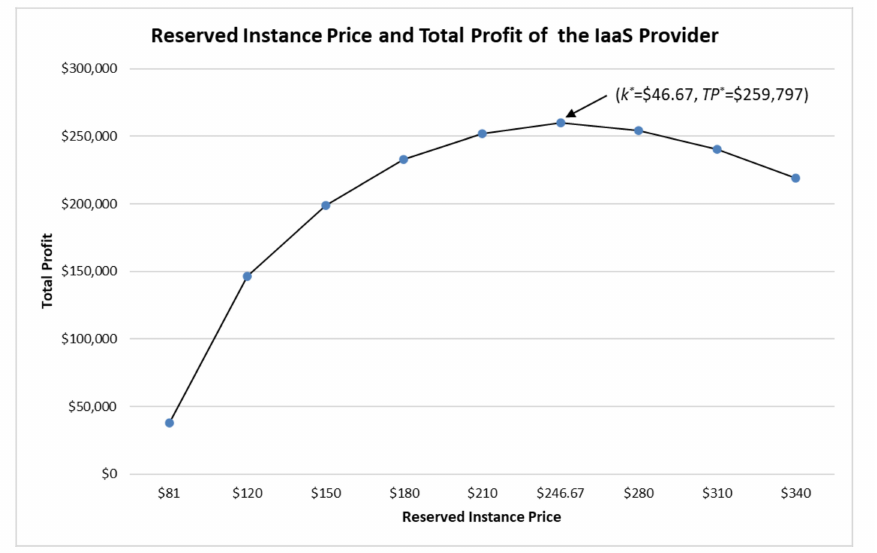
Figure 1. Reserved Instance Price and the Total Profit of the IaaS Provider.